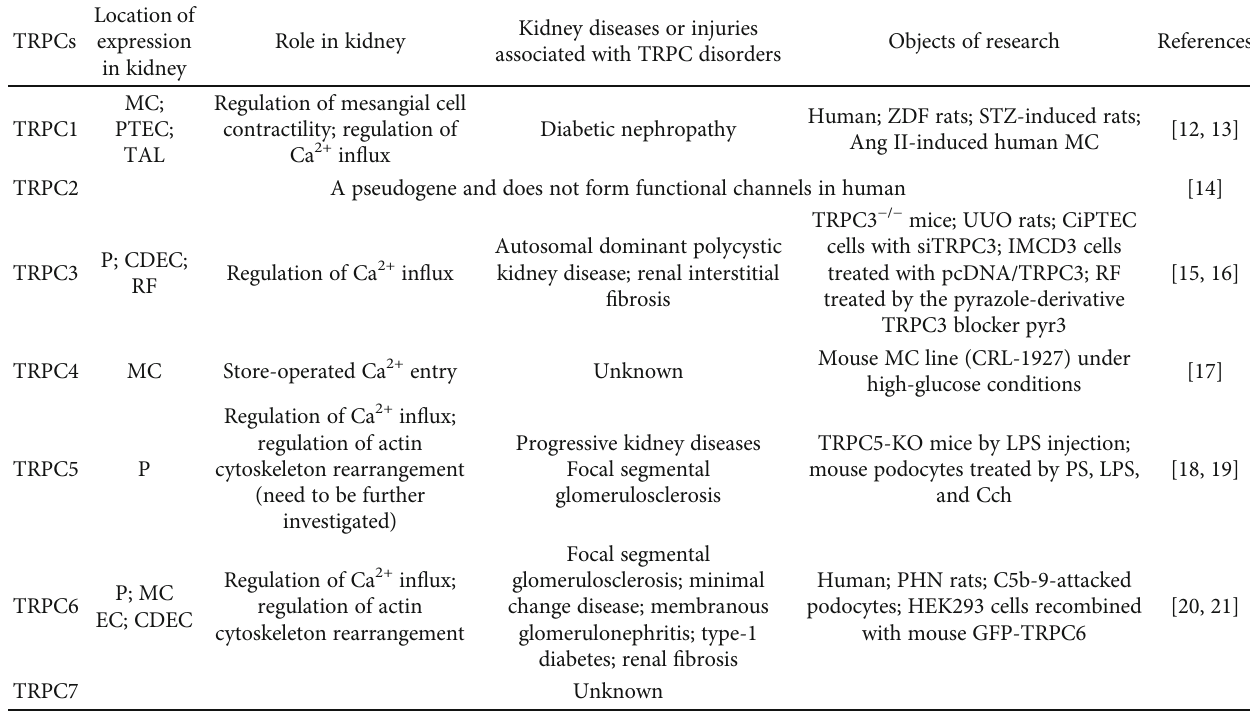
Table 1: Overview of renal expression, function, and associated disorders of